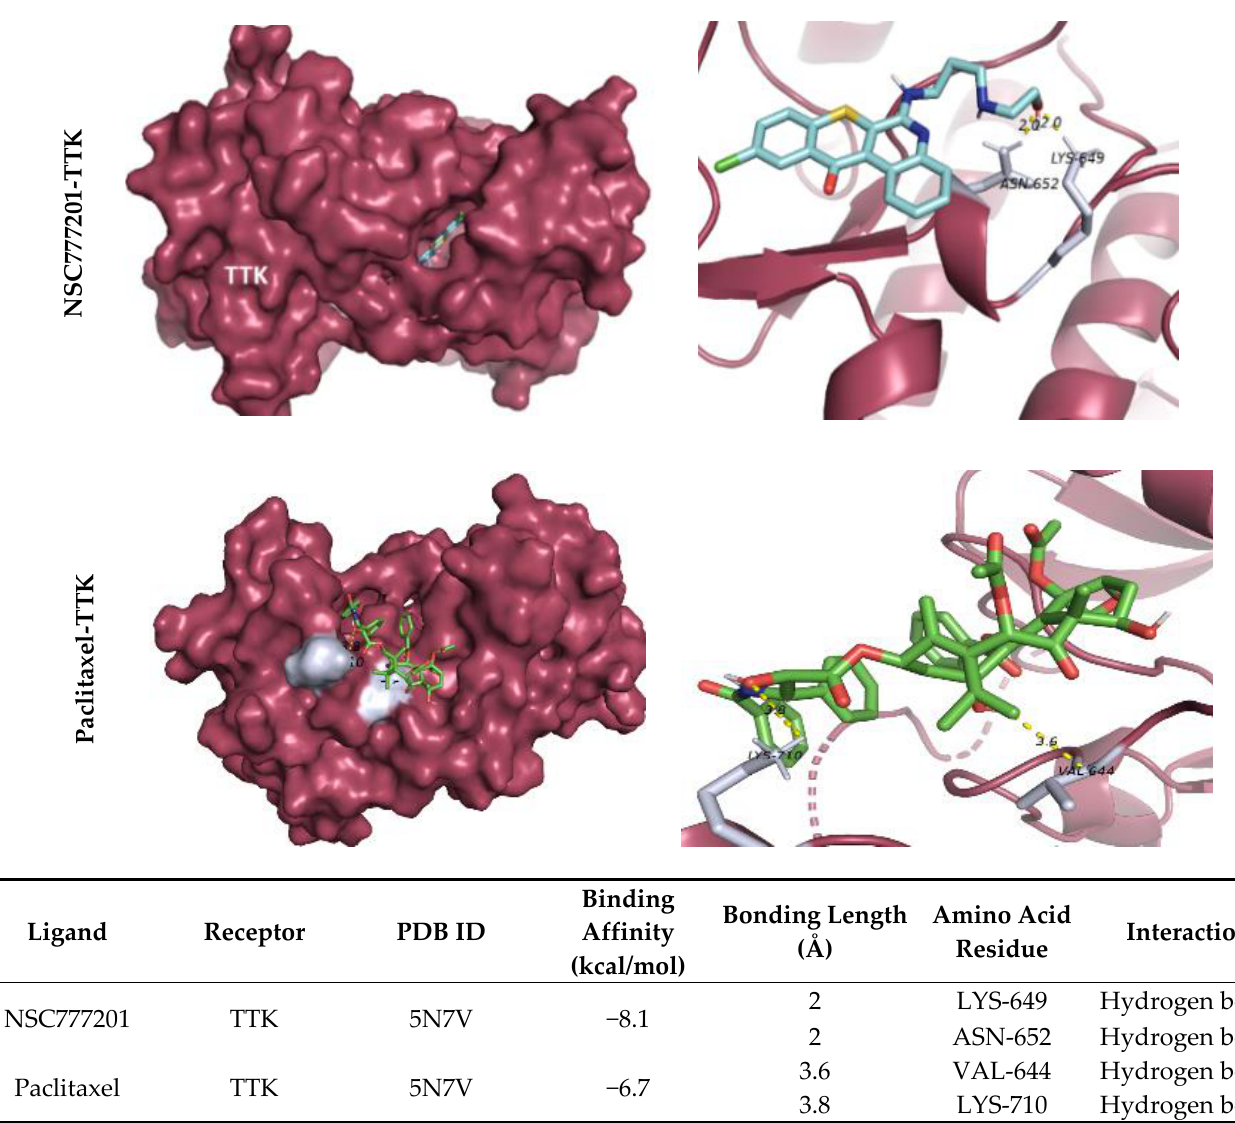
Table represents the ligand-receptor interacting atoms, binding affinities, and interacting distances of NSC777201 and TTK. Figure 7. Docking profile of TTK with NSC777201 and paclitaxel (a known inhibitor). 3D structure of ligand-receptor interactions shown in the left panel. The right panel shows the 2D representation of the interaction with ligands and the receptors in the binding pocket.